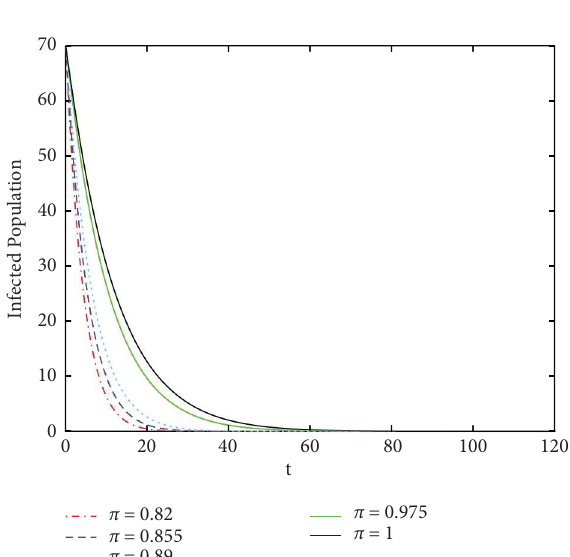
Figure 10: Te dynamics of infected human population for various fractional orders υ and for fractal order π � 0 . 5.